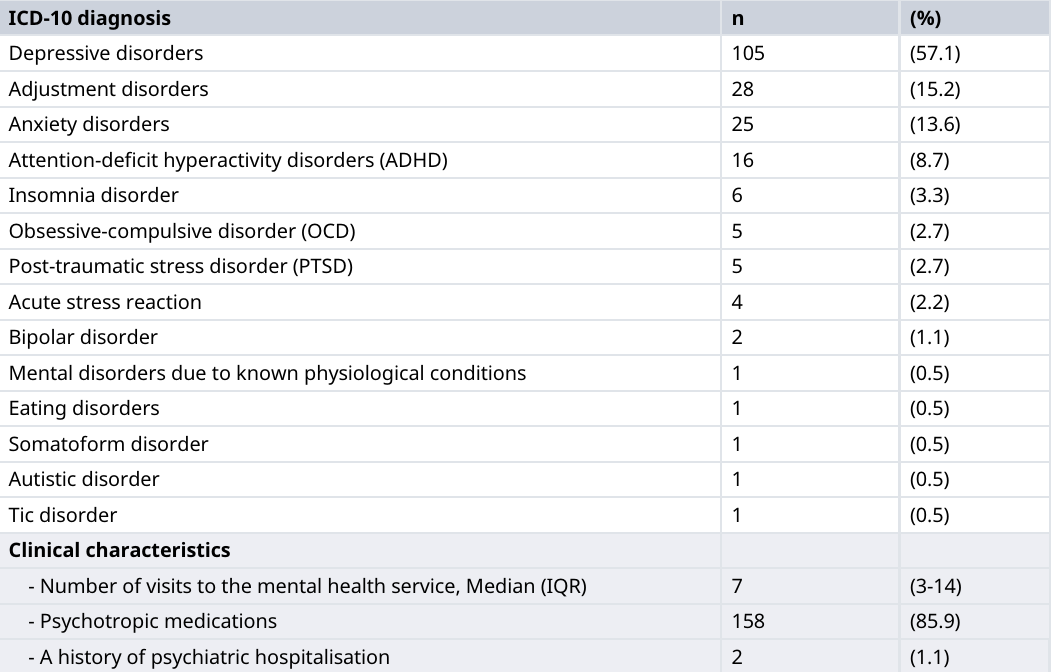
Table 2. Prevalence of common mental disorders and clinical